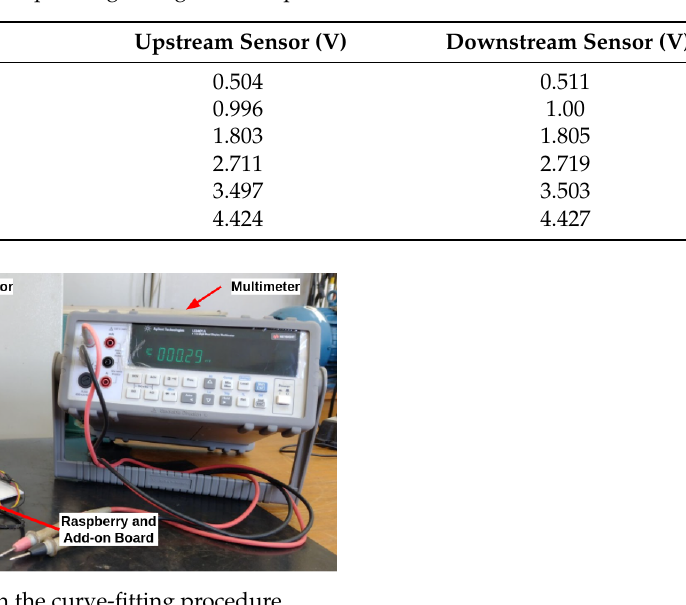
Table 3. Pressures and corresponding voltages for the pressure sensors.